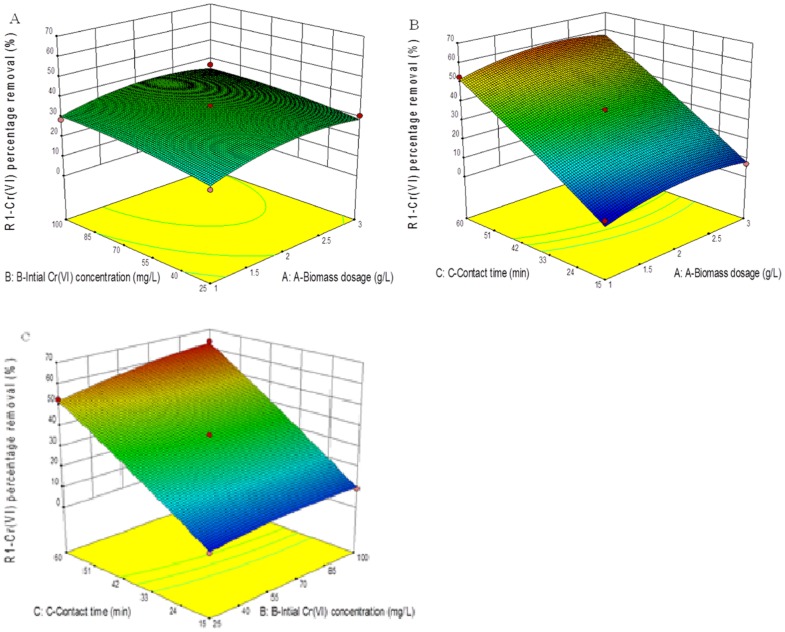
Respone surface plots showing the combined effects of (A) biomass dosage and initial Cr(VI) concentration (B) initial Cr(VI) concentration and contact time (C) contact time and biomass dosage on the removal (%) of Cr(VI).